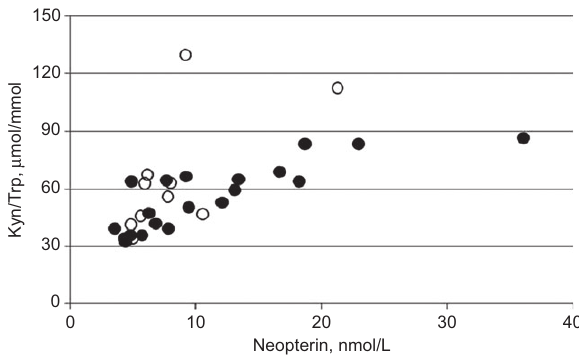
Figure 2 Association between serum kynurenine-to-tryptophan ratios (Kyn/Trp) and neopterin concentrations (r = 0.617, p < 0.01) in 31 patients with coronary artery disease (open circles, 10 females; filled circles, 21